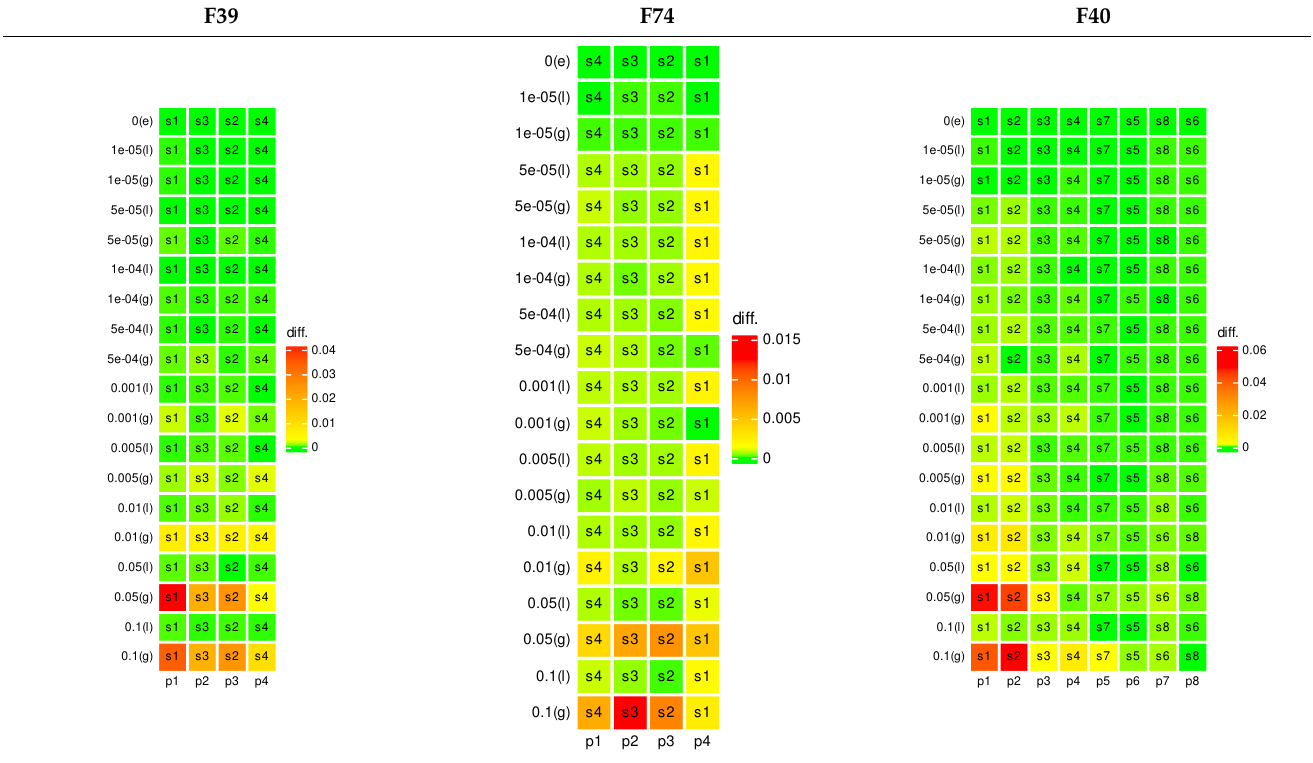
Table 17. Preferences for pathfinder variables.